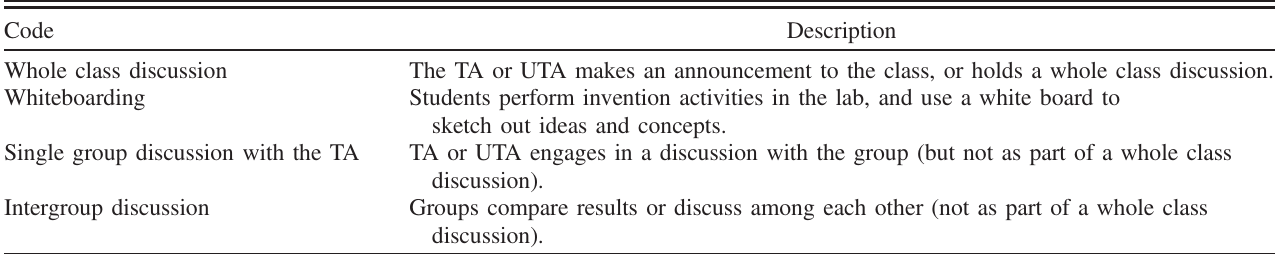
TABLE V. Event codes used in video observations. These codes described significant events in the lab, and were used to decompose the more coarse-grained other code. A sample time series illustrating a coded video is shown in Fig. 5(b).